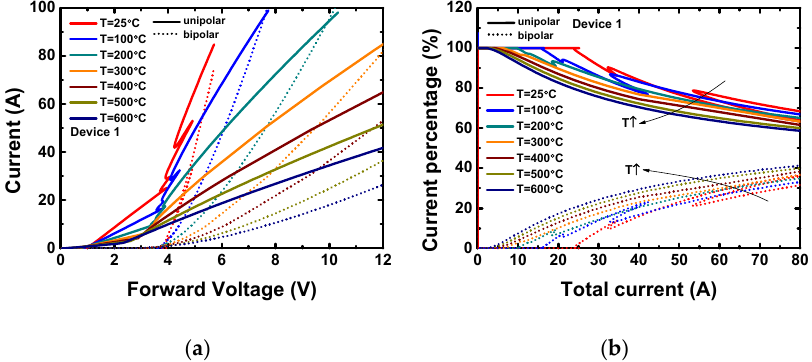
Figure 5. ( a ) The simulated static forward characteristics, with unipolar and bipolar current plotted separately, of Device 1 at T = 25–600 °C. ( b ) The percentage of unipolar and bipolar current in the total current of Device 1 extracted from ( a ) .